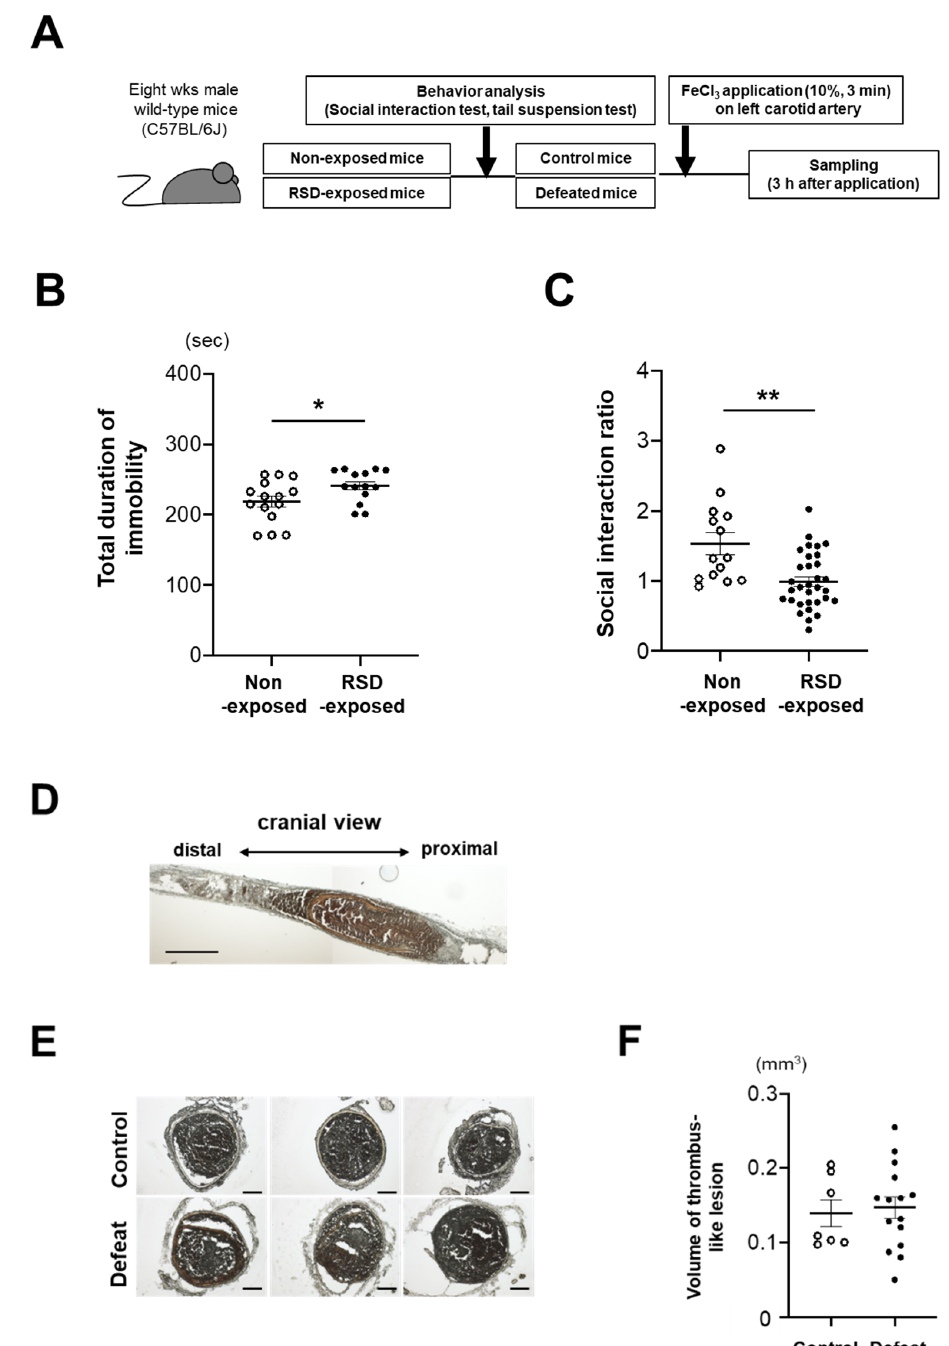
Figure 1. Repeated social defeat does not affect the volume of thrombi after FeCl 3 application. ( A ) Timeline of experimental protocol. ( B ) Tail suspension test. Values represent mean ± standard error of mean (SEM) for 15 non-exposed mice and 14 RSD-exposed mice before application of FeCl 3 . * p < 0.05 vs. non-exposed mice; Student’s t -test. ( C ) Social interaction test. Values represent mean ± standard error of mean (SEM) for 14 non-exposed mice and 32 RSD-exposed mice before FeCl 3 application. ** p < 0.01 vs. non-exposed mice; Student’s t -test. RSD, repeated social stress. ( D ) Representative photographs of FeCl 3 -induced thrombus in the left carotid artery of wild-type (WT) mice. Scale bar = 500 µ m. ( E ) Representative photographs of FeCl 3 -induced thrombus in control and defeated mice. Scale bar = 100 µ m. ( F ) Quantitative analysis of the volume of thrombi in control and defeated mice. Values represent mean ± standard error of mean (SEM) for 7 control mice and 15 defeated